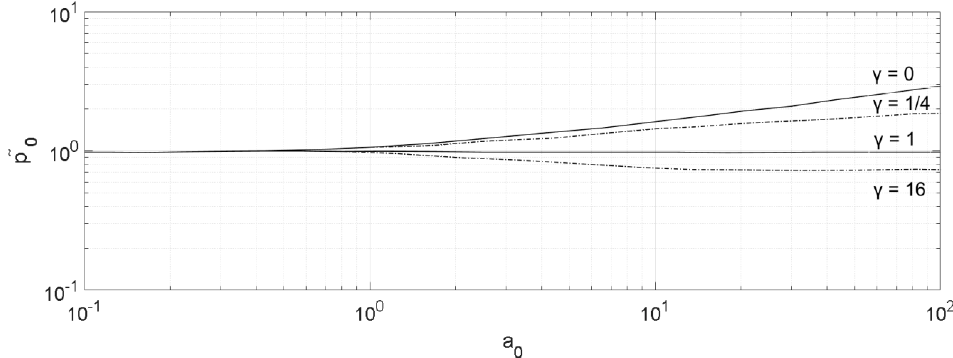
Figure 4. Pressure (cid:101) p as a function of a 0 ( δ = γ ) 0 Figure 4. Pressure p(cid:3556) (cid:2868) as a function of a (cid:2868) ( δ = γ ) [26].